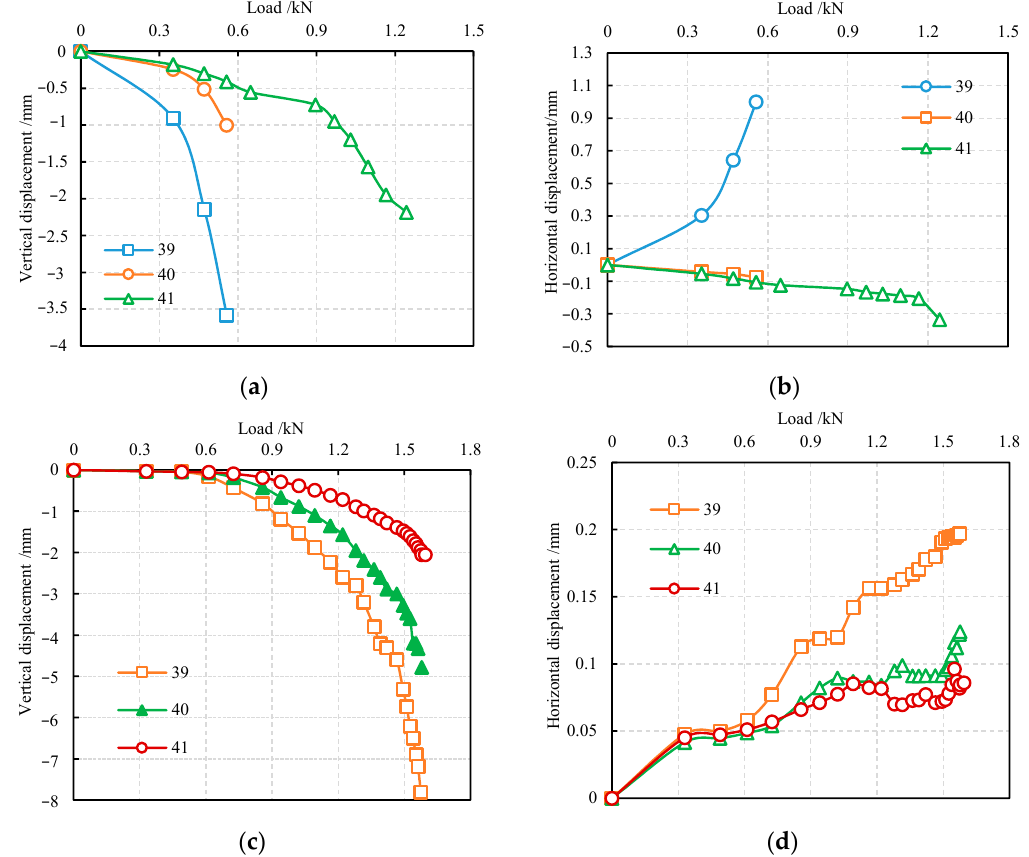
Figure 15. The relationship between displacement and the load at different burial depths under the pile bottom: ( a ) vertical displacement in the undisturbed soil; ( b ) horizontal displacement in the undisturbed soil; ( c ) vertical displacement in the sand; ( d ) horizontal displacement in the sand.